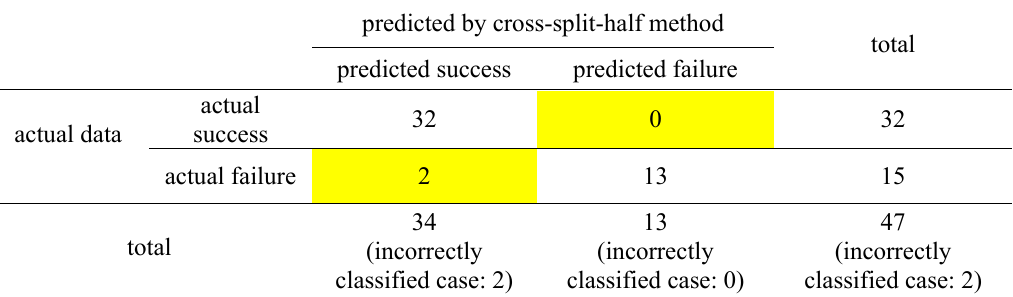
Table 4. Discriminant Results of Cross-Split-Half